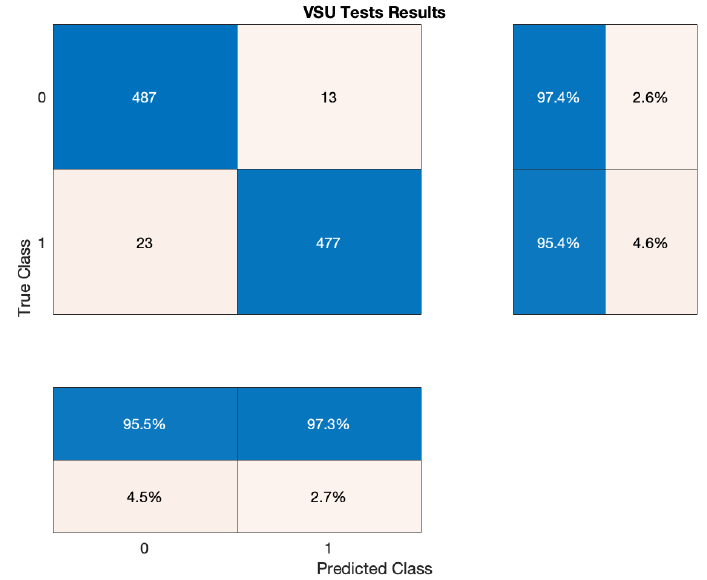
Figure 13. Confusion matrix relative to VSU